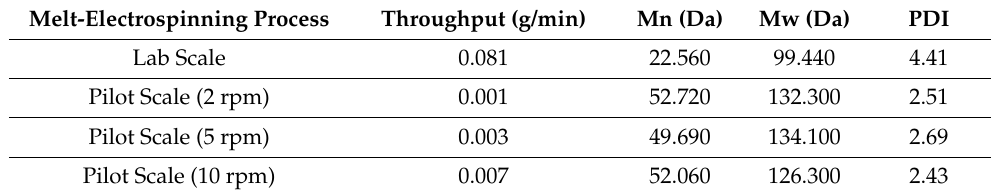
Table 3. The weight average relative molecular weight (Mw), number average molar mass (Mn), and polydispersity index (PDI) of PBS fibers processed at laboratory-scale (throughput of 0.081 g/min) and pilot-scale (throughput of 0.001, 0.003, and 0.007 g/min), both at 235 ◦